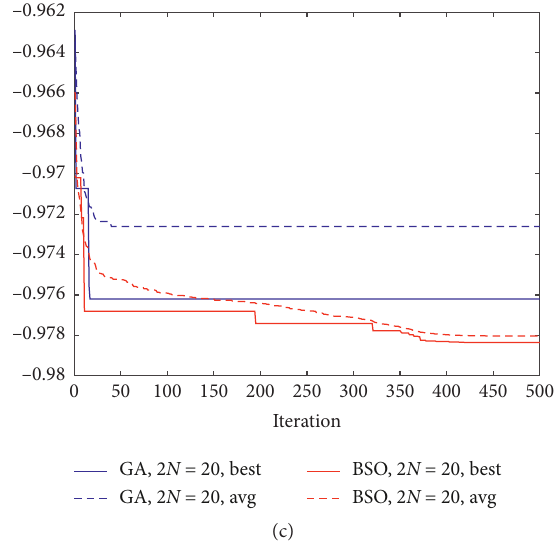
Figure 6: Comparative study on fitness: (a) 2 N � 10; (b) 2 N +1 � 15; (c) 2 N �